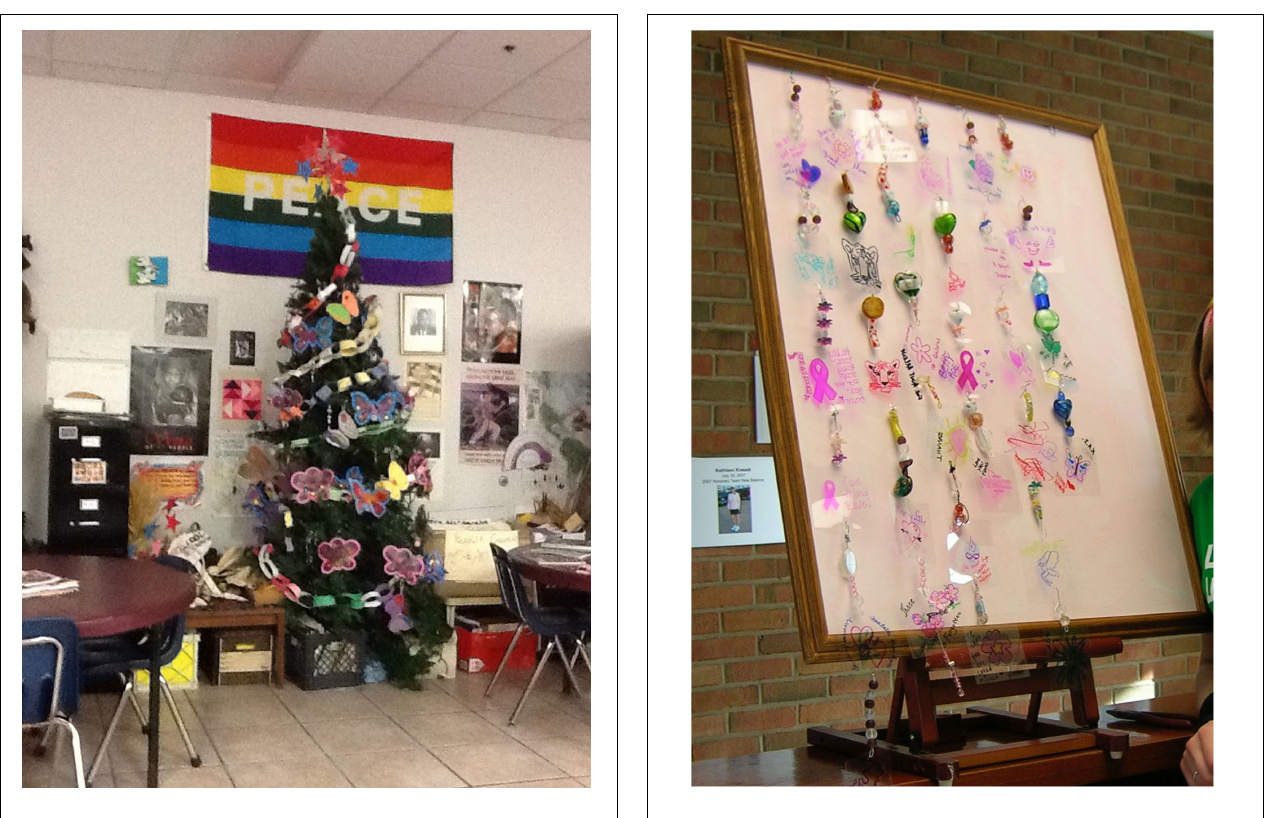
class who facilitated the creative activity desired. However, in an end of semester focus group, the race personnel expressed that